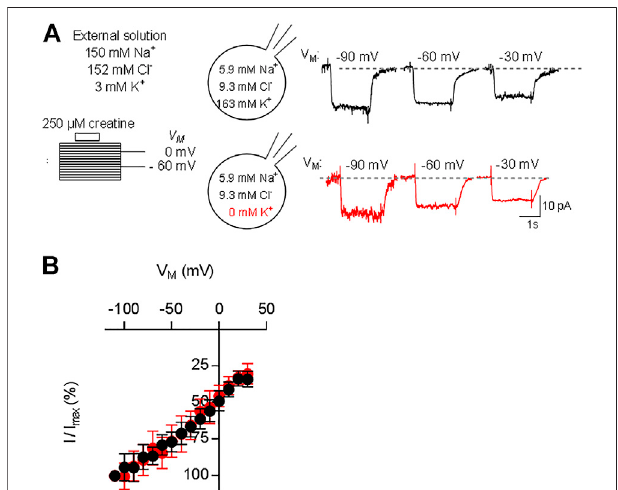
FIGURE 4 | Current-voltage relation of CRT-1. A&B: HEK293 cells transiently expressing CRT-1 were clamped at membrane potentials ranging from − 110 mV to +30 mV for 15 s. During each step 250 µM creatine was applied for 2 s. In panel (A) , the schematic representation on the left hand side illustrates the recording condition, i.e. the extracellular and the intracellular ion concentrations and the voltage steps. Representative traces were recorded at − 90, − 60 and − 30 mV in cells fi lled with a pipet solution containing 163 mM K + (top row, right hand side of panel A) or NMDG (bottom row, right hand side of panel A). Data from 12 independent recordings (means ± S.D.) in the presence of 163 mM intracellular K + (black circles) and the absence of intracellular K + (red circles) are summarized in panel (B) for the indicated voltage range. Current amplitudes at each voltage (I) were normalized to the current amplitude recorded at -110 mV (I max ) to account for cell-to-cell variation in expression